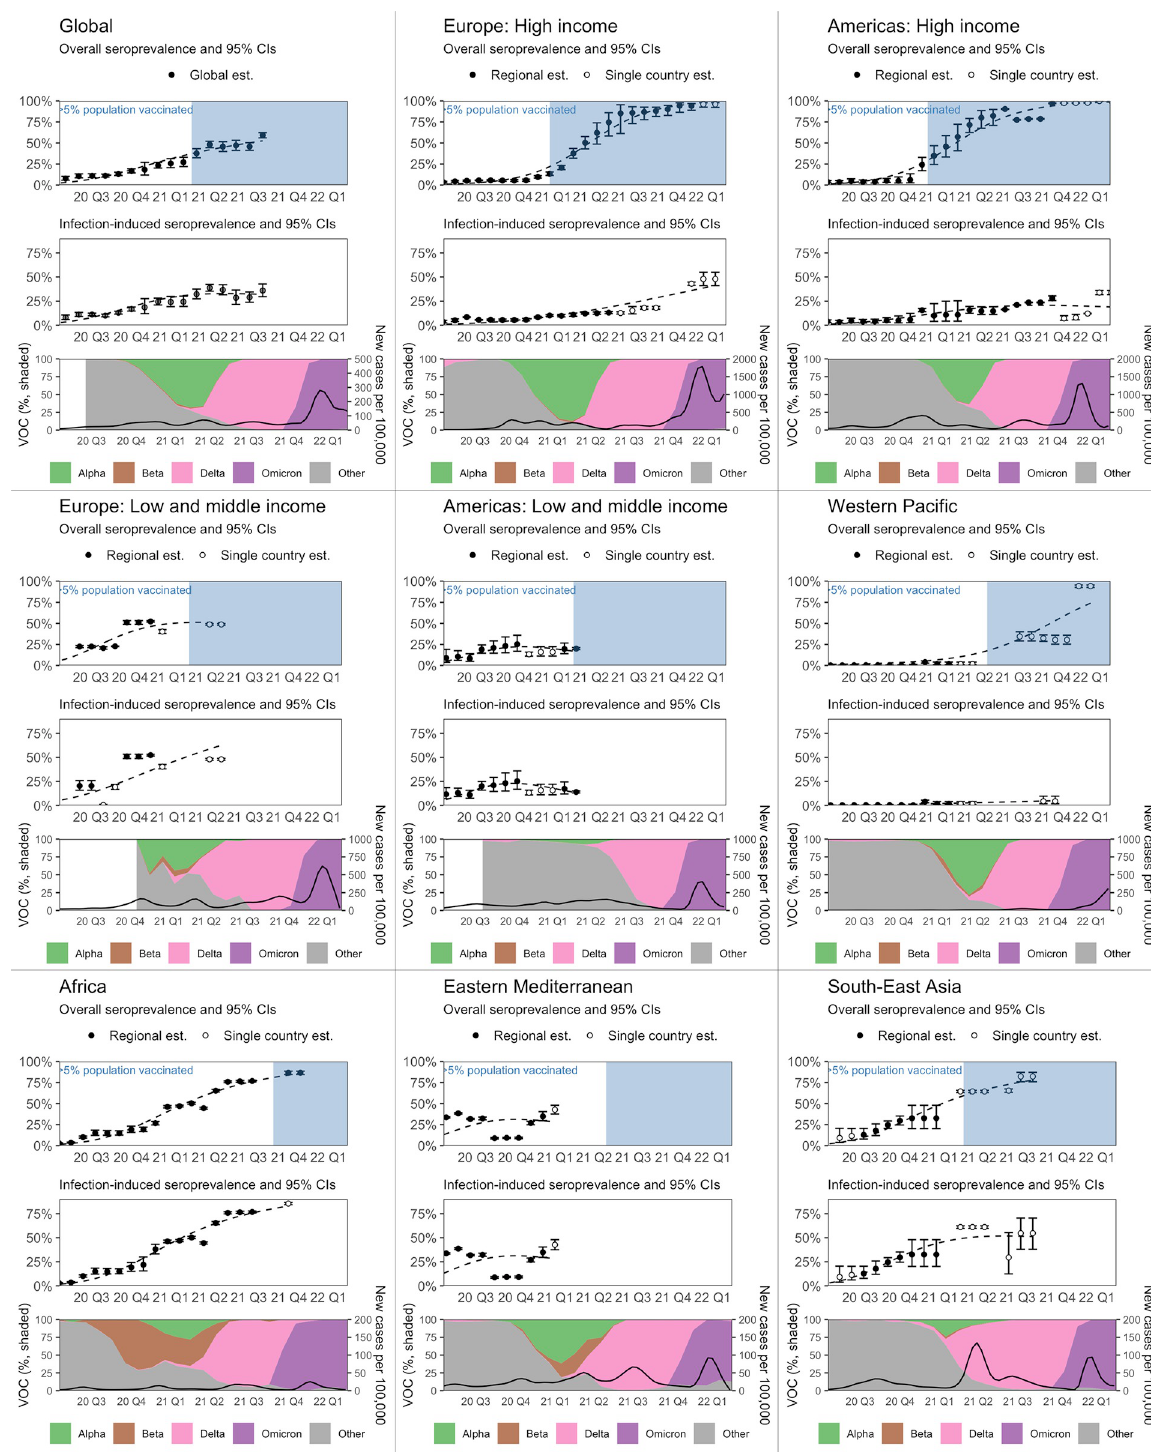
Fig 2. Estimated seroprevalence globally and by WHO region from January 2020 to March 2022. The figure contains 9 boxes showing the global analysis and 8 WHO regional analyses. Each box contains the following panels. Top and middle panel: We produced weighted point estimates and 95% CIs of overall (top) and infection-induced (middle) seroprevalence by meta-analyzing studies in 12-week rolling windows. To visualize the trend in seroprevalence in each WHO region and globally, we fit a flexible, smooth function of time (dashed line) to the point estimates using nonparametric regression (full details: File H in S1 Materials). Countries included in each region-month estimate are in Table